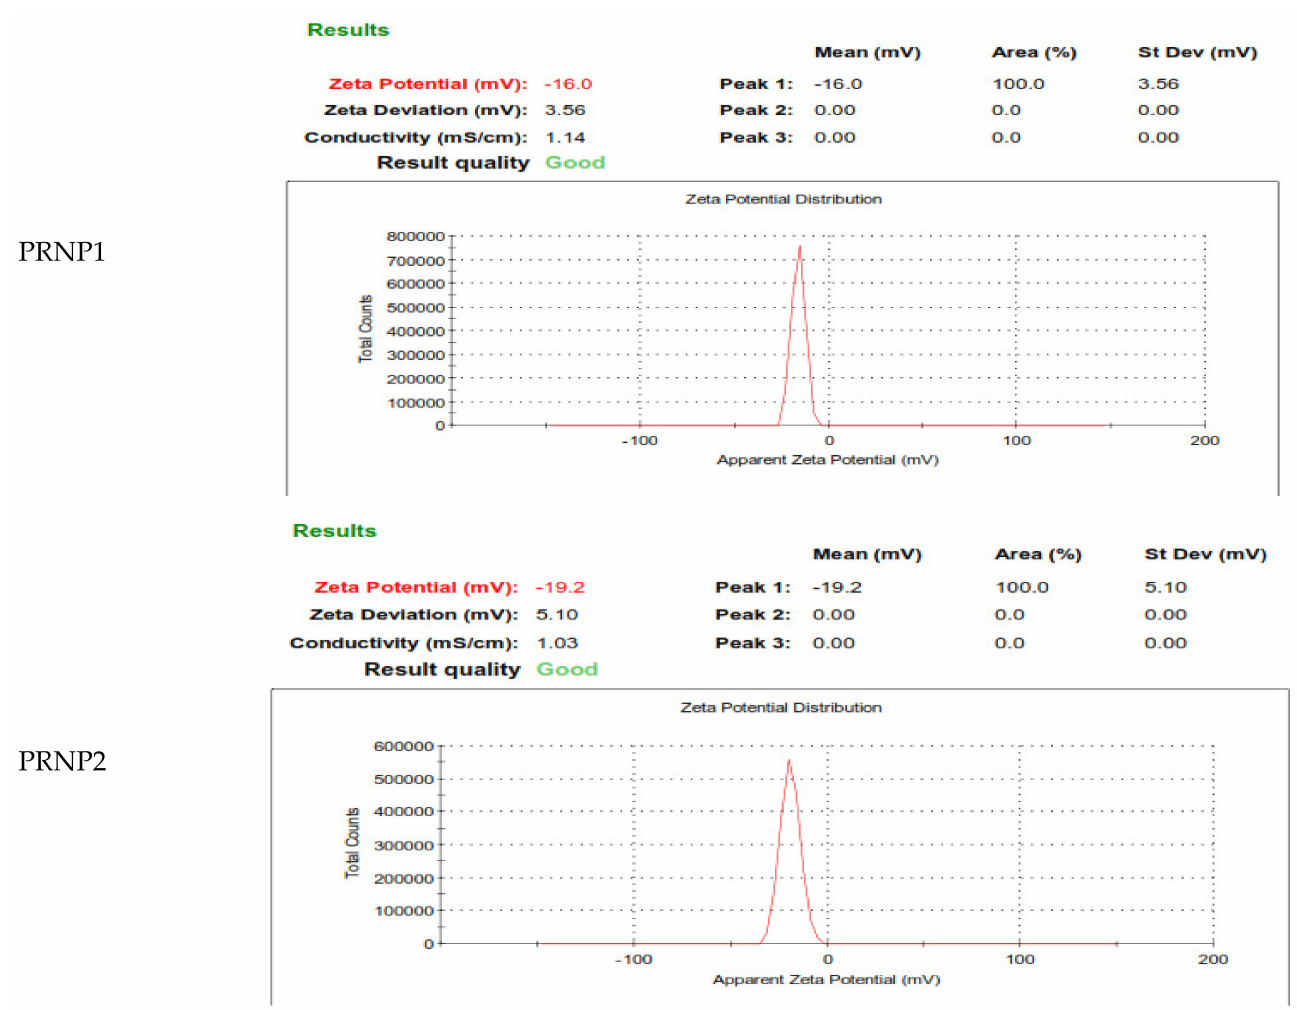
Figure 3. Zeta potential values for the prepared polymer nanoparticles of doxycycline prepared by nanoprecipitation technique.